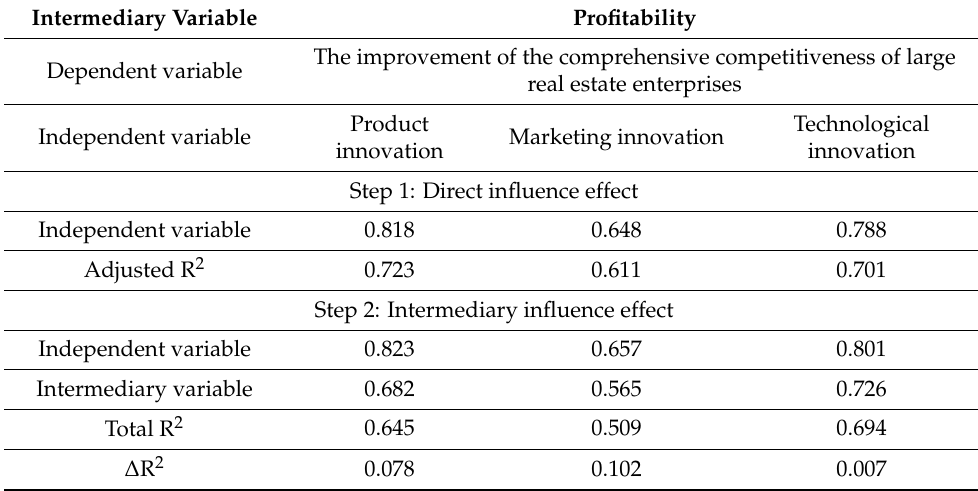
Table 8. Test results of the intermediary effect of